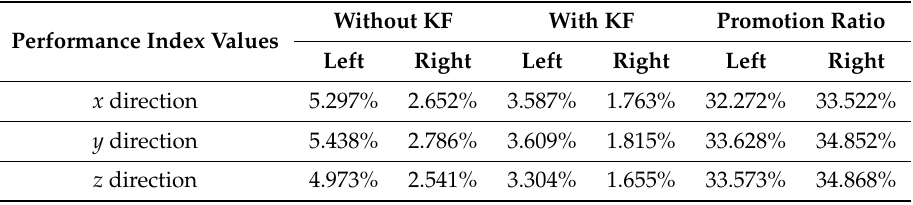
Table 1. Performance index table in different directions with & without KF sensor